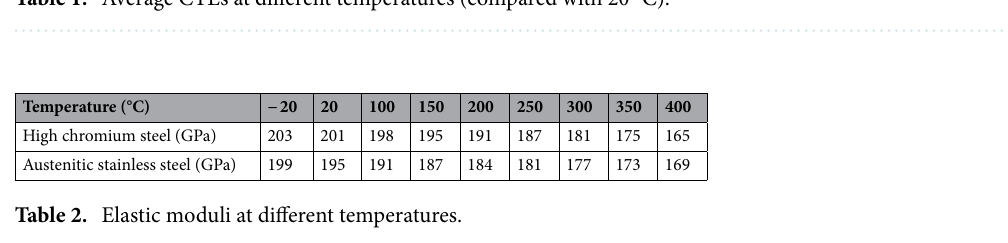
Table 1. Average CTEs at different temperatures (compared with 20 °C).